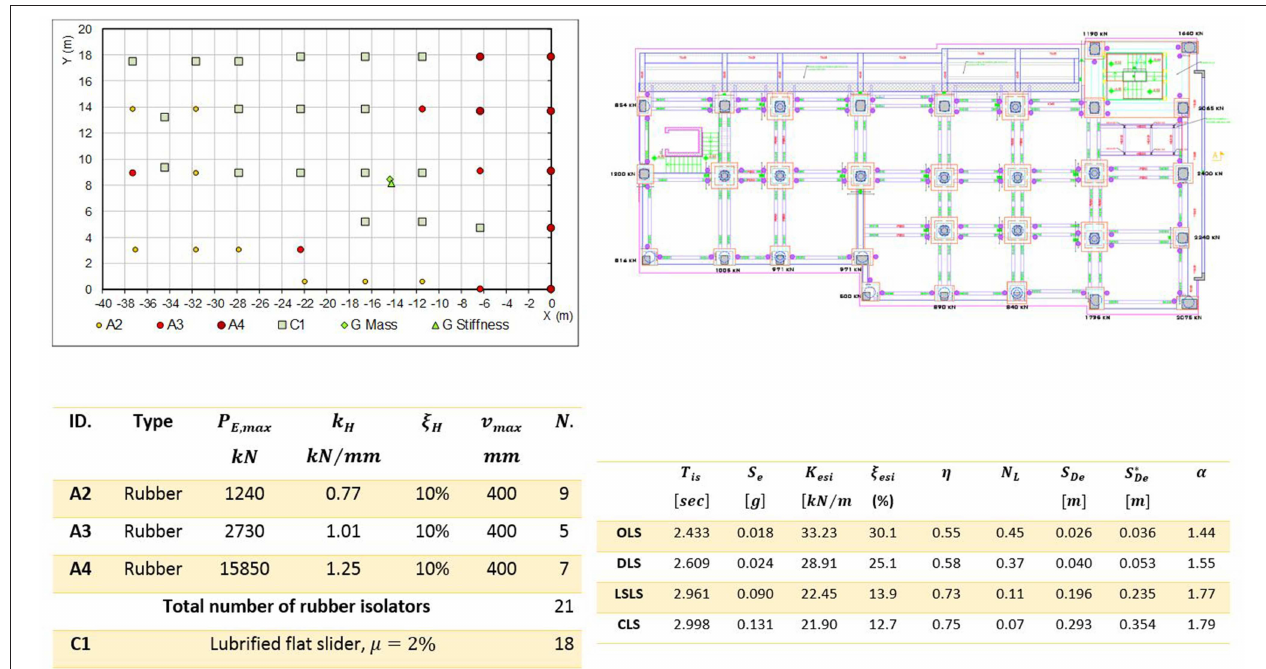
FIGURE 9 | Seismic isolating system: configuration and details. Where: A2, A3, and A4 are the three types of rubber isolator considered, C1 is the flat slider, G Mass, and G Stiffness are the positions of the center of masses and center of stiffness, respectively.